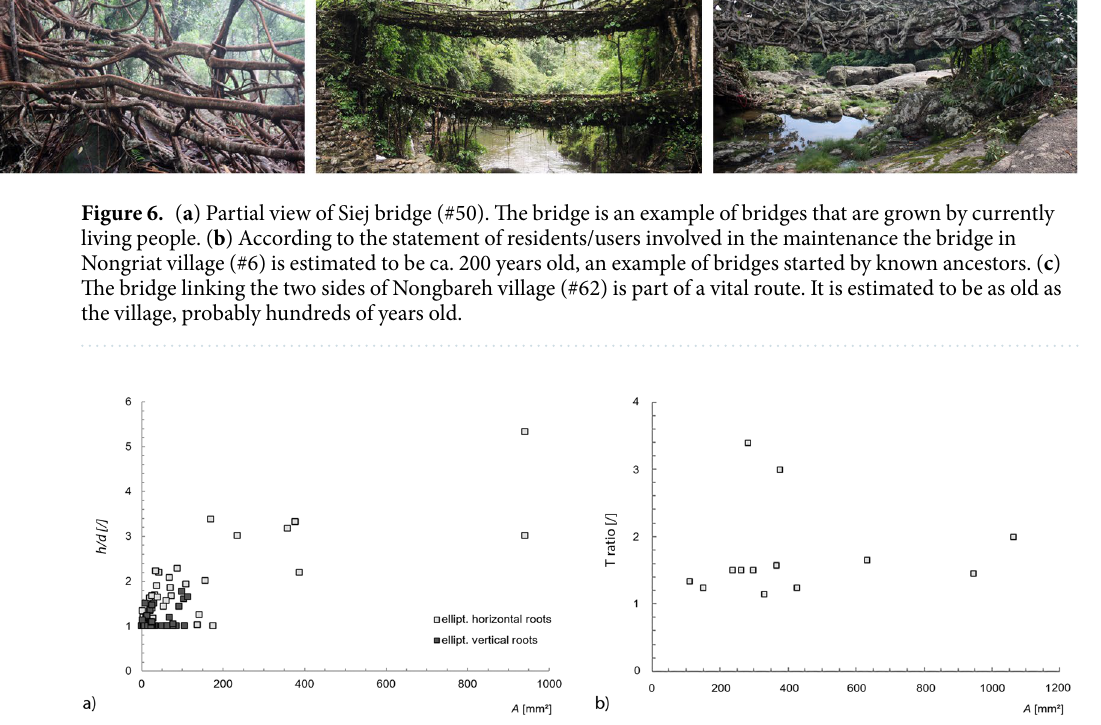
Figure 7. Root geometry. ( a ) Ratio of height to width (h/d) and cross-sectional area (A) of horizontally and vertically trained roots with an elliptical cross-section. ( b ) T-ratio and cross sectional area (A) of horizontally trained roots with a T-shaped cross-section (vertically oriented roots did not show T-shape).